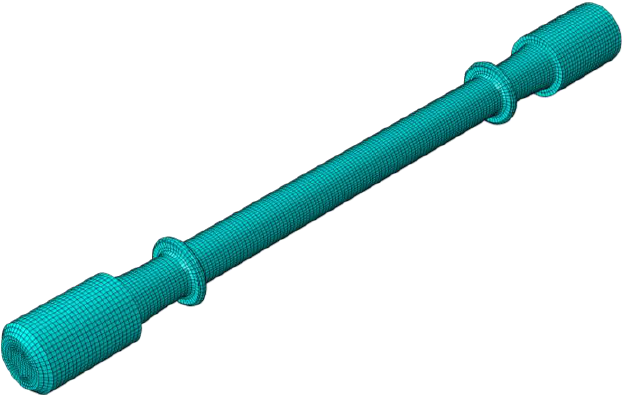
Figure 8. Meshed model of the creep specimen.